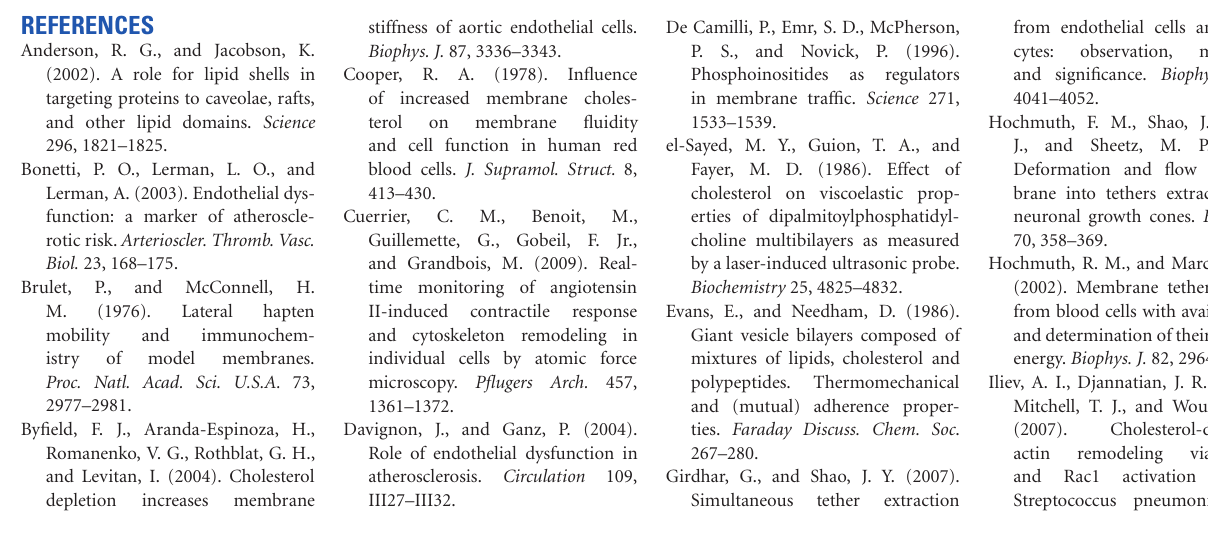
FIGURE 6 | Schematic illustration of the hypothesized cholesterol regulation of PIP2 function in BAEC. Left: cholesterol induces the formation of low-density lipid plasma membrane microdomains, such as caveolae, and facilitates PIP2 hydrolysis and thus its loss of cross-linker function. Right: cholesterol depletion destructs caveolae, thus reduces PIP2 hydrolysis and restores PIP2’s cross-linker function.